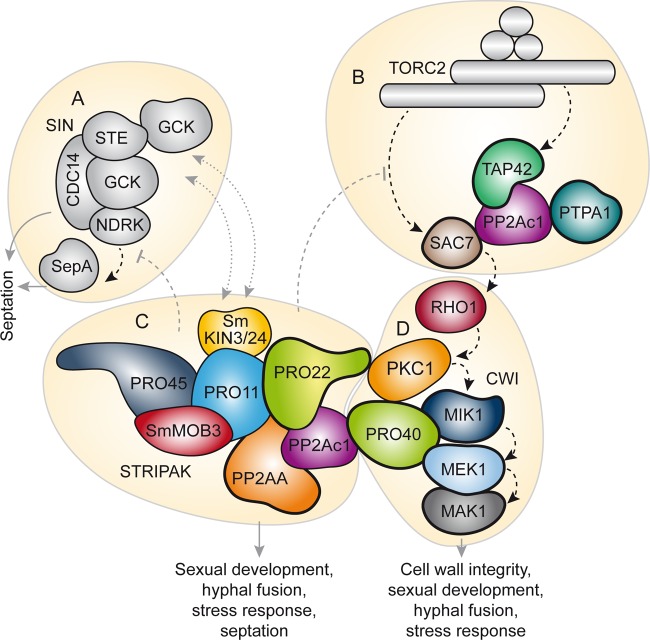
The interconnected signaling pathway of sexual development in S. macrospora. On the basis of functional characterization and protein-protein interaction studies, STRIPAK (C) hypothetically interacts with the SIN (A), TORC2 (B), and the CWI pathway (D). (A) The SIN is composed of three kinases and an adjacent kinase (78). Phenotypic analysis of STRIPAK mutants and TAP-MS data suggest a functional relationship between the SIN and STRIPAK in S. macrospora (27). (B) TORC2 targets TAP42, and SAC7 interacts with PP2Ac1. SAC7 is a GTPase-activating protein and regulates the small GTPase RHO1, a subunit of the CWI pathway (25). (C and D) Several STRIPAK and CWI pathway subunits interact, and cell wall stress-related growth defects in the Δpp2Ac1, Δpro22, and Δpp2Ac1 Δpro22 mutant strains point toward a relationship between the two pathways. Models of STRIPAK and CWI pathways are adapted from references 27 and 25, respectively. Interaction partners of PP2Ac1 are framed by bold lines. Solid gray arrows, dashed black arrows, dashed gray lines, and dotted gray lines indicate functions, signaling pathways, negative regulation, and putative translocation, respectively. GCK, germinal-center kinase.